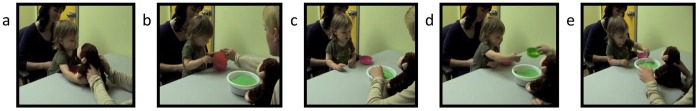
Five phases of the main experiment.Toddlers were (a) introduced to a puppet and (b) given eight treats. Then, in counterbalanced order, each toddler (c) watched as the experimenter gave one treat to the puppet, (d) was asked to give a “found” treat to the puppet, and (e) was asked to give one of their own treats to the puppet.